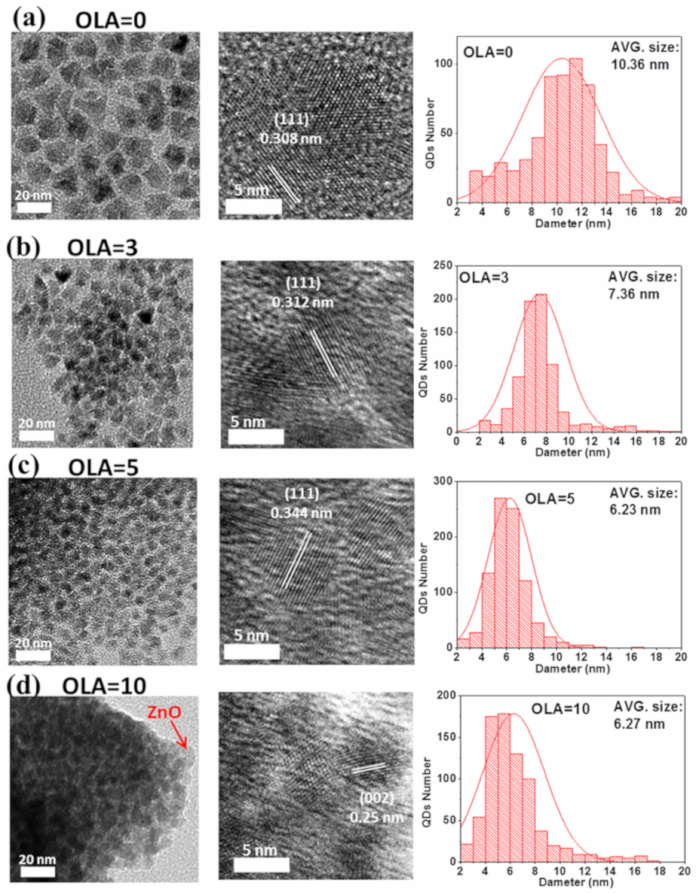
Figure 2. Top-view HRTEM images and the size distributions of QDs with ( a ) OLA = 0, ( b ) OLA = 3 ( c ) OLA = 5, and ( d ) OLA = 10